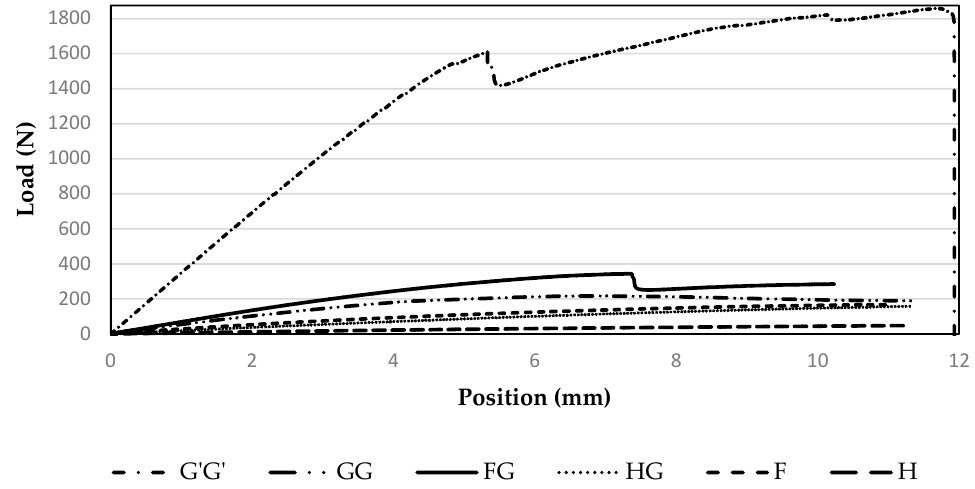
Figure 5. Flexural load-position curves of the composites containing commercial glass fiber (G’G’), glass fiber (GG), flax and glass fiber (FG), hemp and glass fiber (HG), flax alone (F) and hemp alone (H).